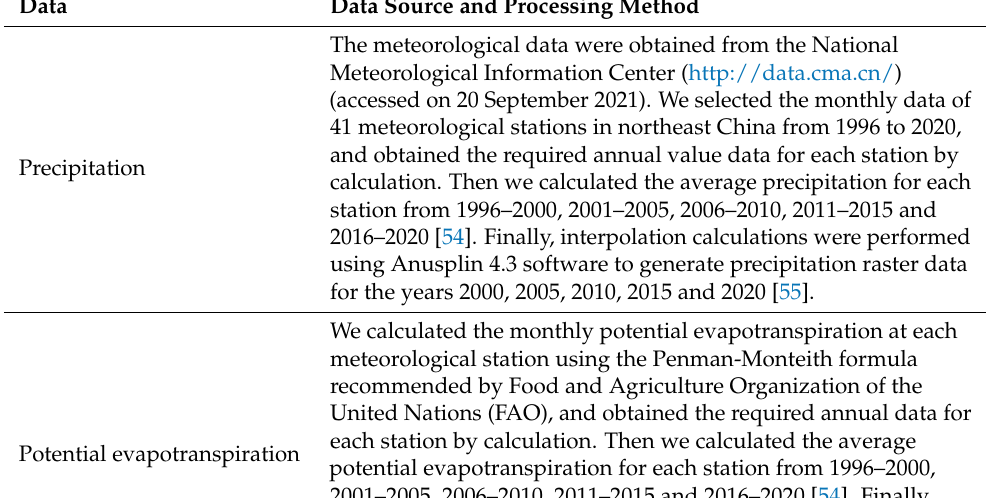
Table 1. Acquisition and preprocessing of the